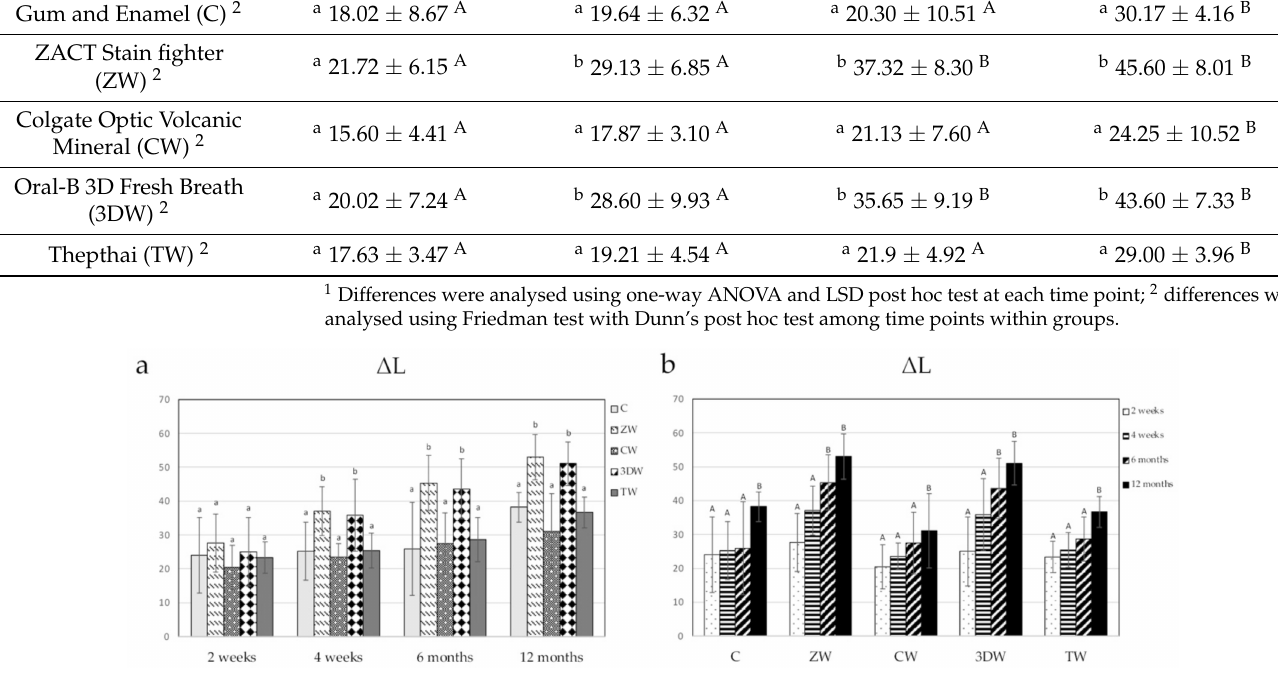
Figure 4. ( a ) ∆ L after brushing at each time point analysed using one-way ANOVA and LSD post hoc test. Different lowercase letters indicate statistically significant differences among toothpaste groups ( p < 0.05). ( b ) ∆ L after brushing among time points was analysed using Friedman test with Dunn’s post hoc test. Different capital letters indicate statistically significant differences only among the evaluation periods in the same groups ( p < 0.05).